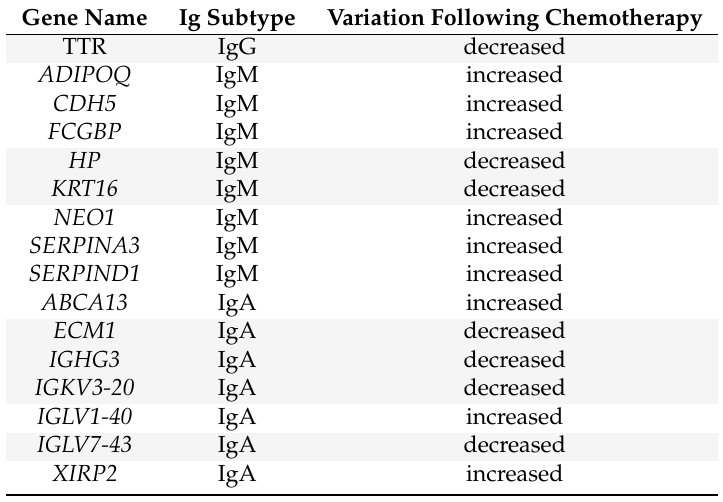
Table 1. List of differentially recognized Circulating Immune Complexes.